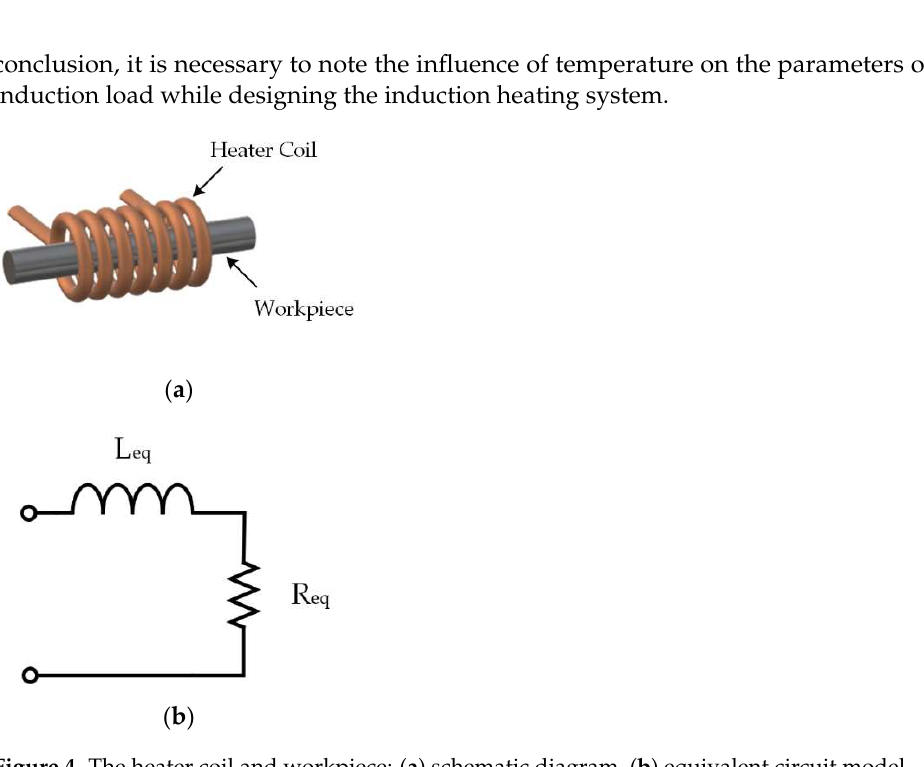
Figure 4. The heater coil and workpiece: ( a ) schematic diagram, ( b ) equivalent circuit model.